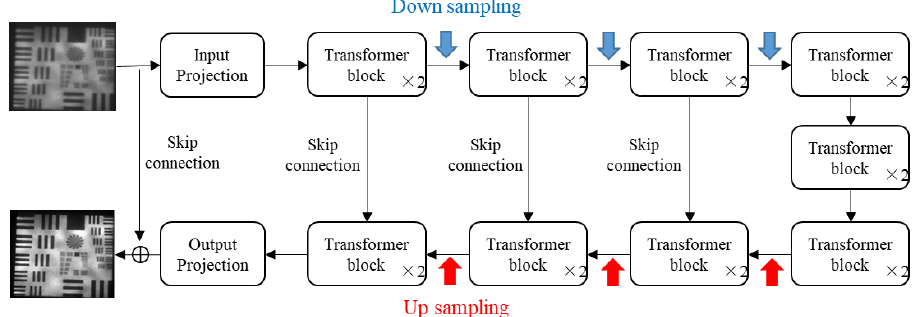
Figure 5. Model architectures for image deblurring.